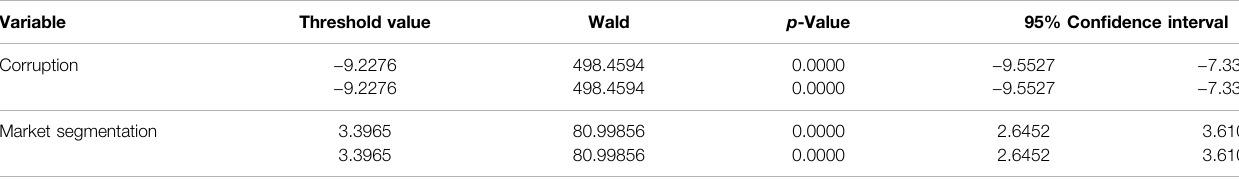
TABLE 5 | The threshold tests.